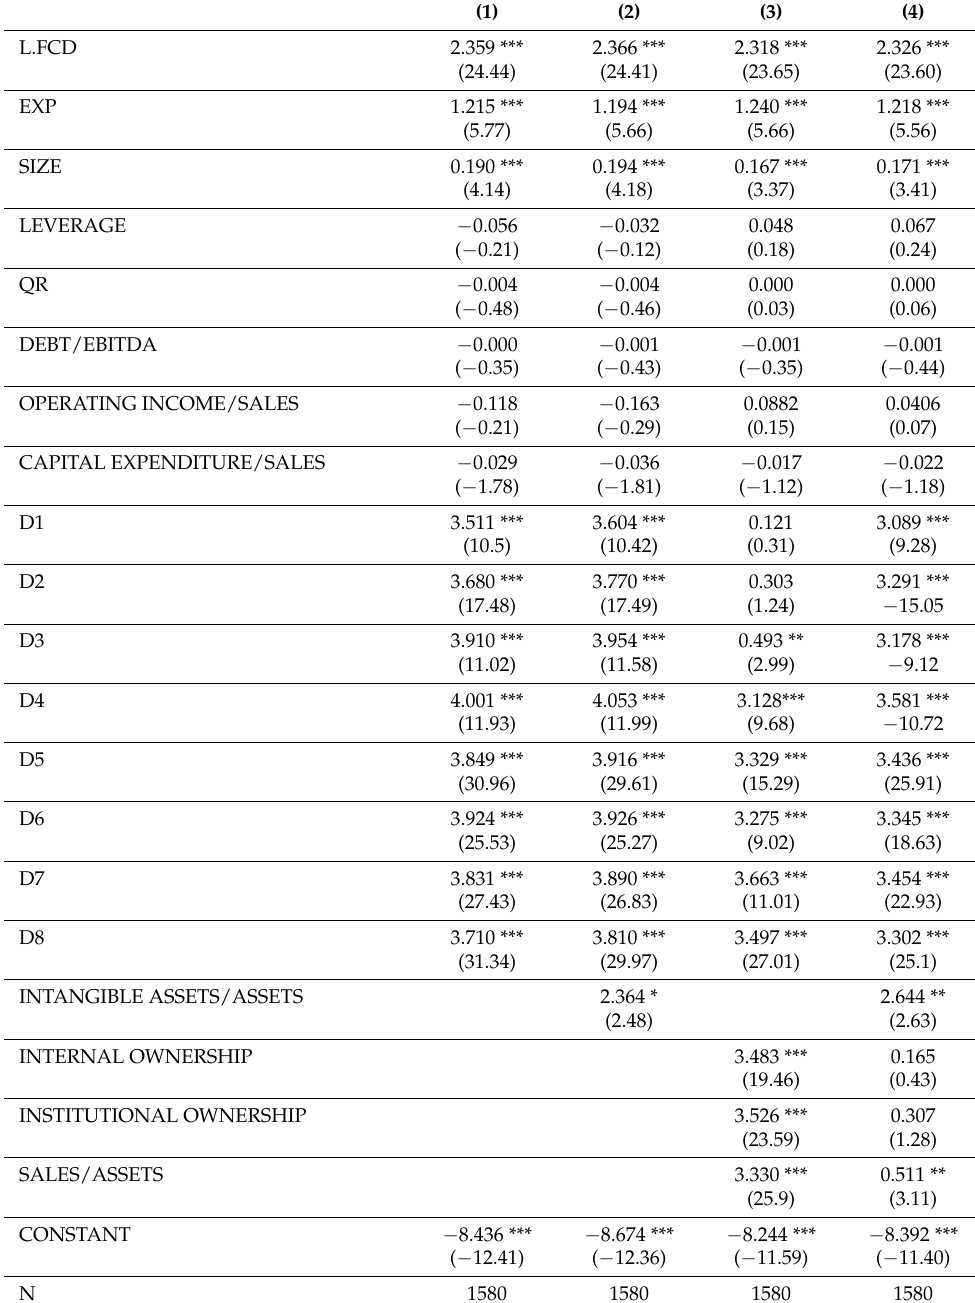
Table 6. Robustness test for the dynamic model with industry